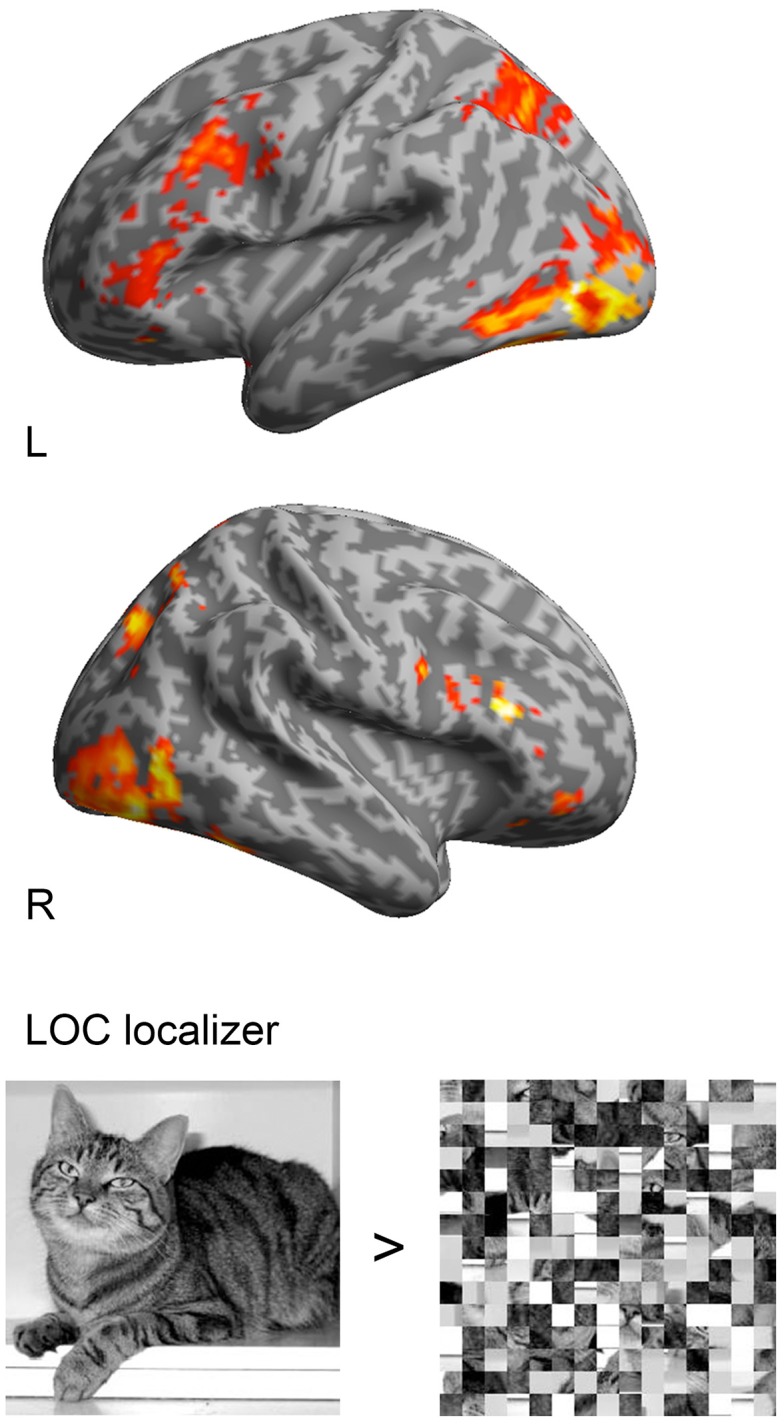
Group analysis (n = 14) of the LOC localizer (objects > scrambled objects) with a threshold of p < 0.05, FSW corrected and superimposed onto a standard 3D inflated template in MNI space. Activations were found in lateral occipital cortex with the MNI coordinates 48, −54, −9 and −45, −54, −15.